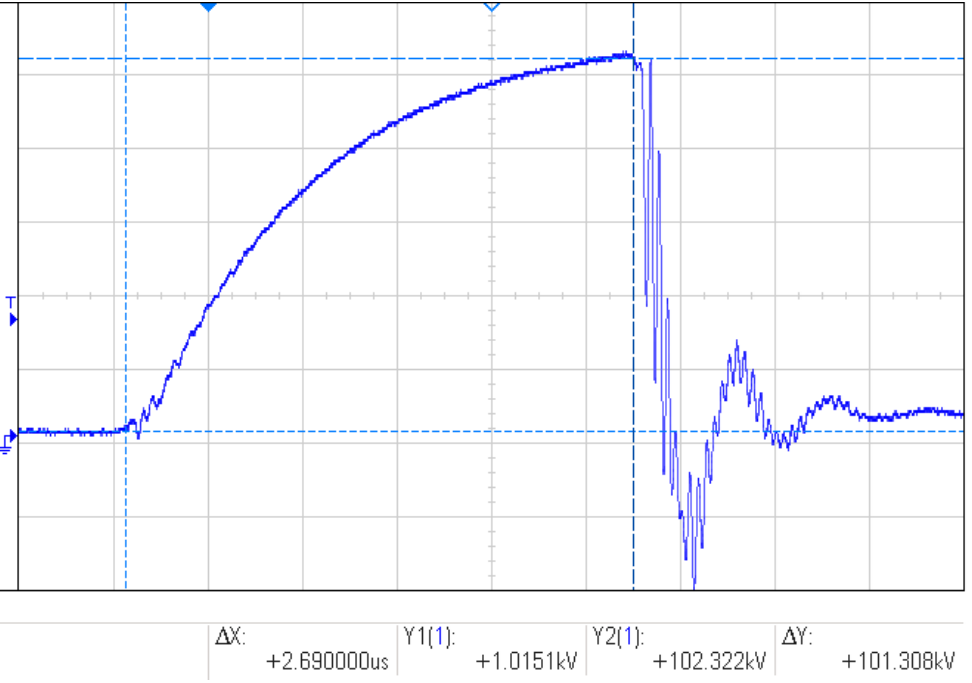
Figure 6. Waveform of voltage as a result of applying a lightning impulse voltage of positive polarity to the MCA for the length of the 20 mm spark gap.